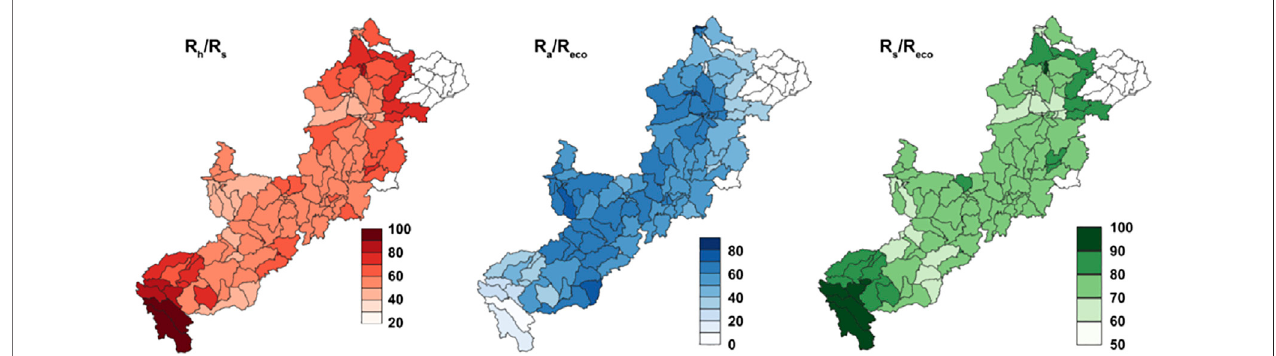
FIGURE 2 | Maps of the average percentage (%) ratios of soil respiration (R s ) and heterotrophic respiration (R h ), autotrophic respiration (R a ) and ecosystem respiration (R eco ), R s and R eco , respectively in 2000 – 2013. The northernmost regions are not modelled and are shown blank.